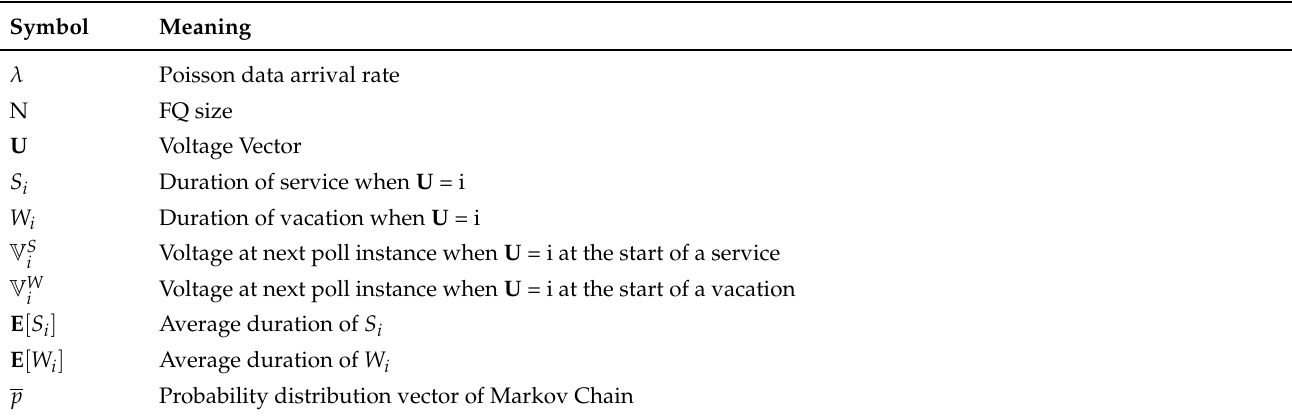
Table A1 summarizes all the important parameters’ symbol with their definition. Table A1. Parameters Used in the Markov Chain